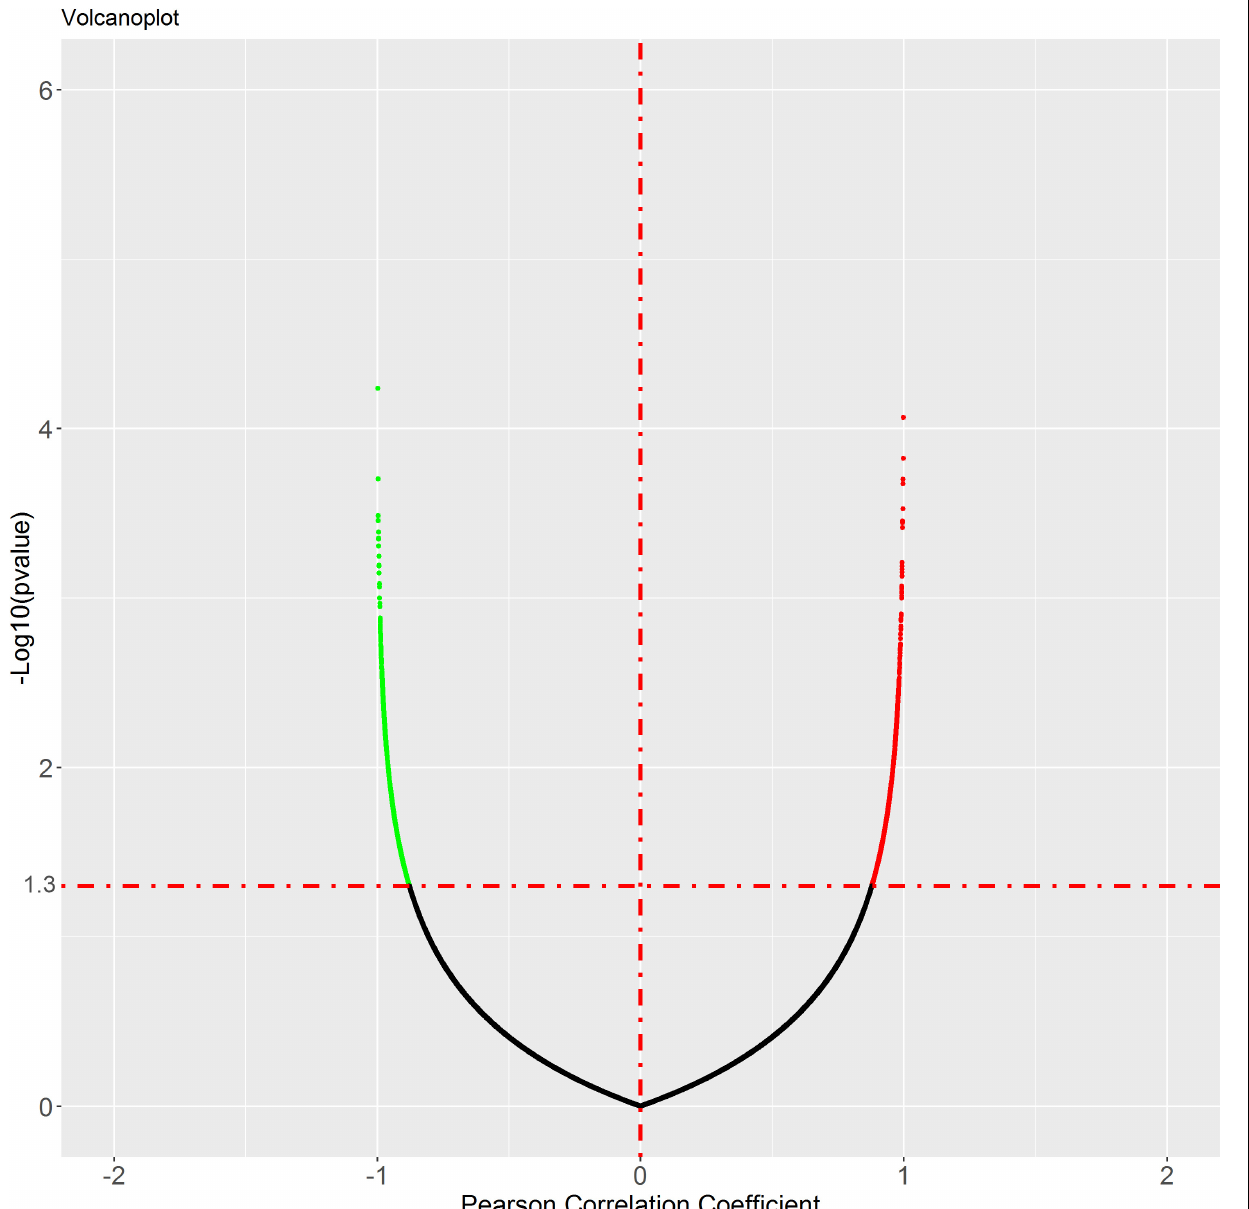
lung tissue samples. All results were graphically presented in volcano plots ( Figure 6 ) ( Supplementary File 2